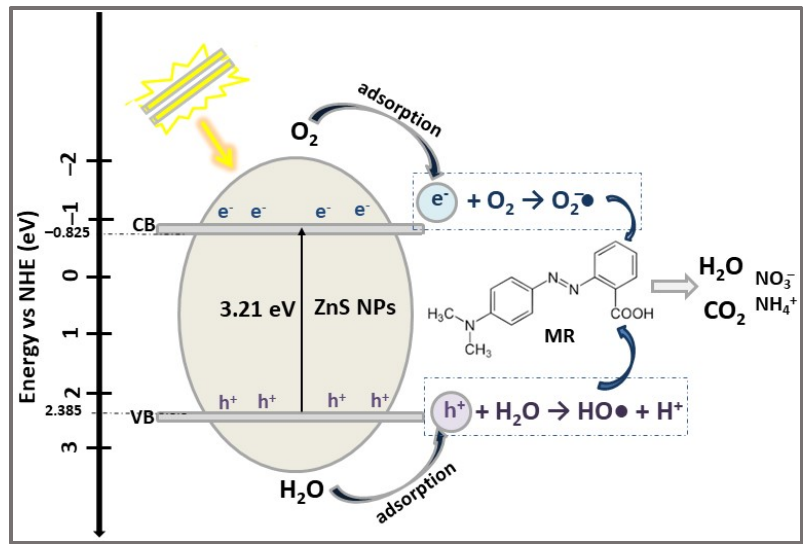
Figure 6. The photocatalytic degradation mechanism of MR dye using ZnS NP photocatalyst in Vis light irradiation for 2 h.